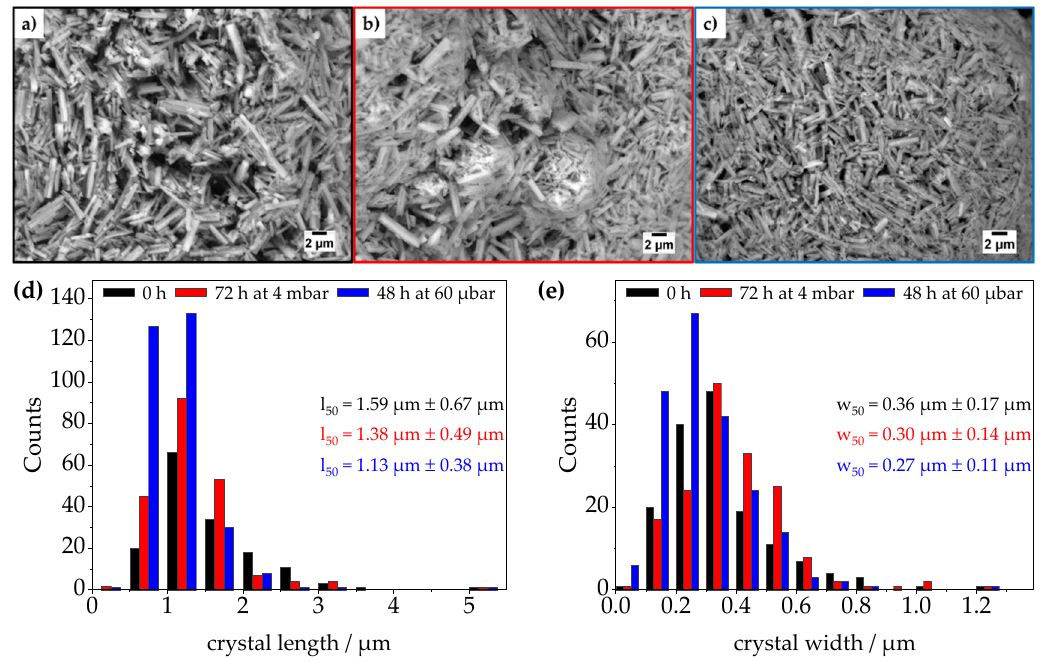
Figure 9. ESEM micrographs of ( a ) pristine synthetic ettringite and treated ettringite after treatment at three different levels of low pressure, ( b ) 4 mbar for 72 h, ( c ) 60 µbar for 48 h, ( d ) respective length, and ( e ) width of ettringite’s crystals derived from ESEM micrographs.